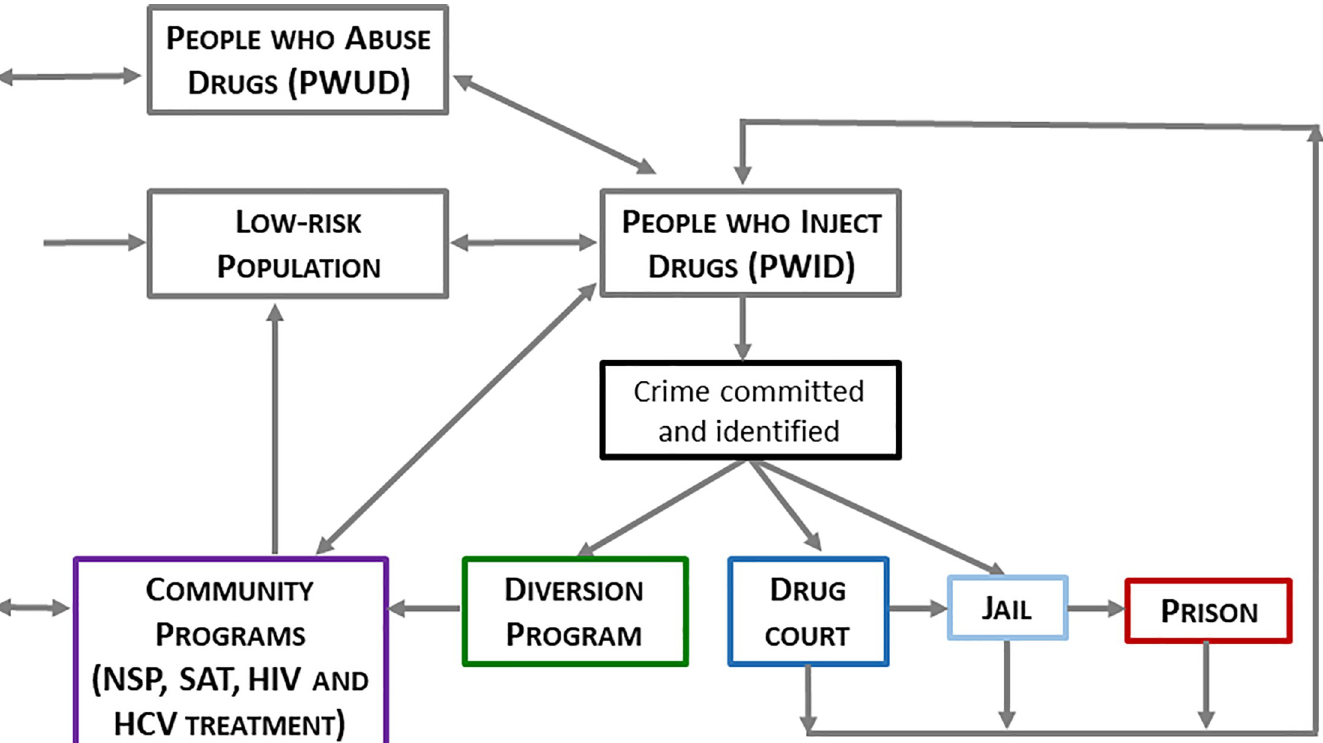
Fig 1. Schematic of jail diversion model. PWUD and PWID flow in and out of community programs, via which a small percentage move to lower-risk populations. In the absence of a diversion program, individuals move to jail at the time a crime is committed and identified and will possibly move on to prison, depending on the nature of the crime. A diversion program diverts individuals from the criminal justice system into community programs. In this simplified model schematic, some arrows (e.g., deaths) have been omitted for visual clarity. HCV, hepatitis C virus; NSP, needle and syringe program; PWID, people who inject drugs; PWUD, individuals with substance use disorder who do not inject drugs; SUDT, treatment for substance use